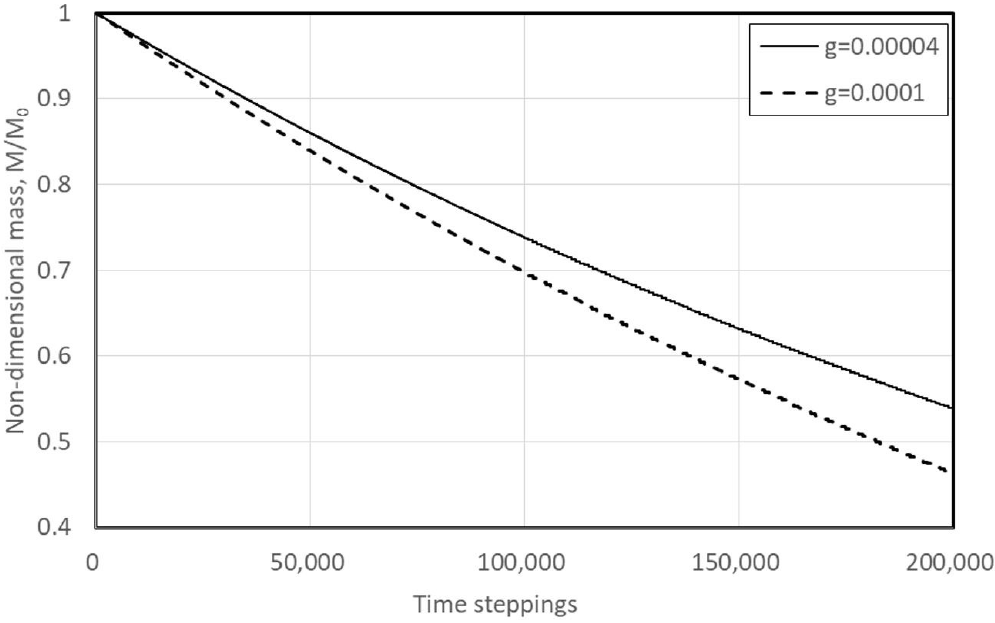
Figure 5. Mass variation with time step under different force fields in the NEE boundary